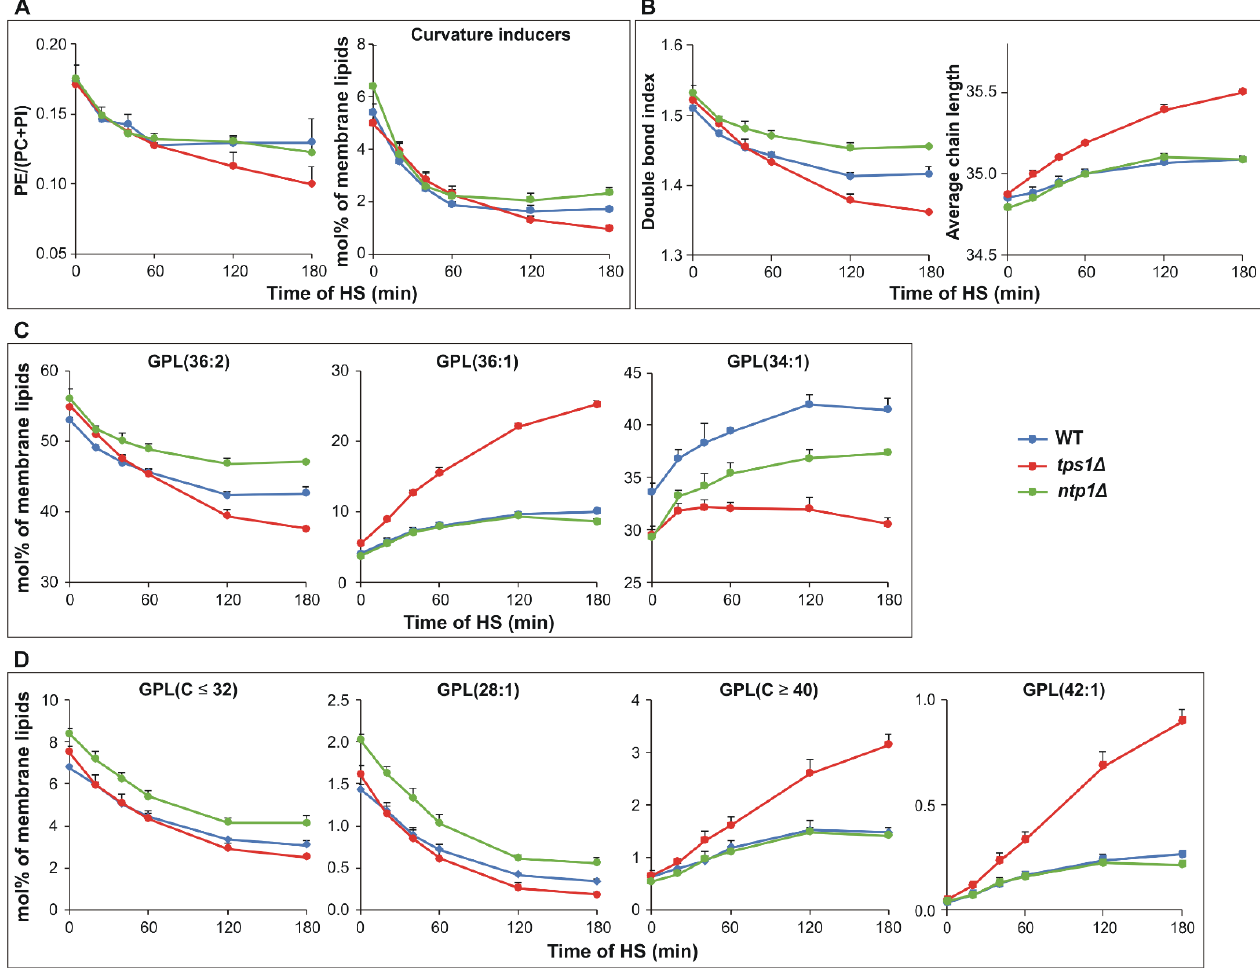
Figure 4. Heat-induced membrane lipid remodeling. Yeast cells were heat-stressed at 40 °C for 0–180 min. ( A ) Changes in PE/(PC+PI) ratio and curvature-inducing lipids comprising lyso GPLs, mono- and dimethyl-PE. ( B ) Alterations in double bond index and average acyl chain length. ( C ) Kinetics of major membrane lipid species GPL(36:2, 18:1/18:1), GPL(36:1, 18:0/18:1) and GPL(34:1, 16:0/18:1). ( D ) Kinetics of medium-chain FA-containing species GPL(C ≤ 32) such as GPL(28:1, 18:1/10:0) and very long-chain FA-containing species GPL(C ≥ 40) such as GPL(42:1, 24:0/18:1). Data are presented as mean ± SD, n = 3 (independent experiments); for significance values, see Table S3. WT, wild-type; tps1 Δ , trehalose-deficient; ntp1 Δ , trehalase-deficient S. pombe strains; GPL, glycerophospholipids; PE, phosphatidylethanolamine; PC, phosphatidylcholine; PI, phosphatidylinositol.